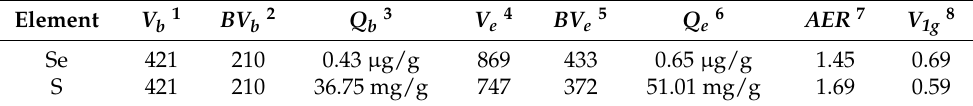
Table 3. Test results for LDH removal of Se and S from plant discharge in testbed